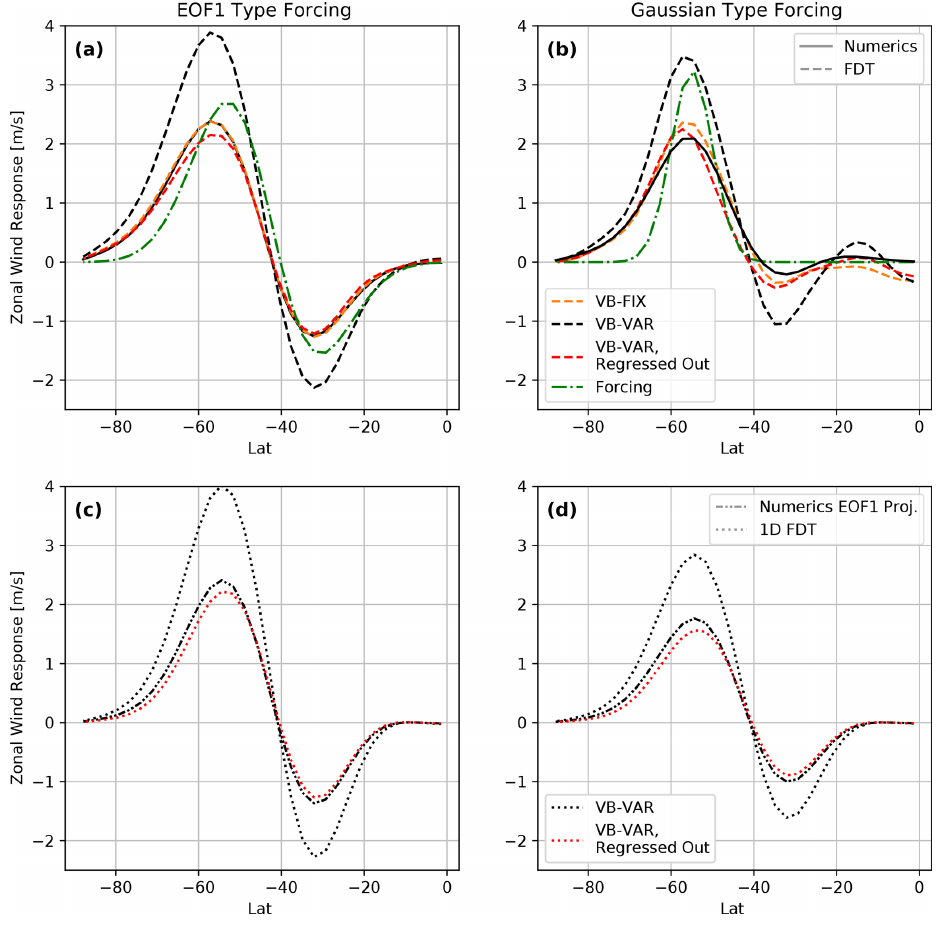
Figure 6. Response to two different types of forcing in the barotropic experiments VB-FIX and VB-VAR: (a) an EOF1-type forcing (exper- iments VB-FIX-EOF1-FOR and VB-VAR-EOF1-FOR) and (b) a Gaussian-type forcing (experiments VB-FIX-Gauss-FOR and VB-VAR- Gauss-FOR). The numerical responses are shown as solid lines and the FDT predictions (using the full method described in Appendix B) as dashed lines. Since the numerical responses of VB-FIX and VB-VAR are almost identical, we omitted the former. (c–d) Same as panels (a) – (b) , but we compare the EOF1 projection of the numerical response with the 1D FDT predictions made using Eq.